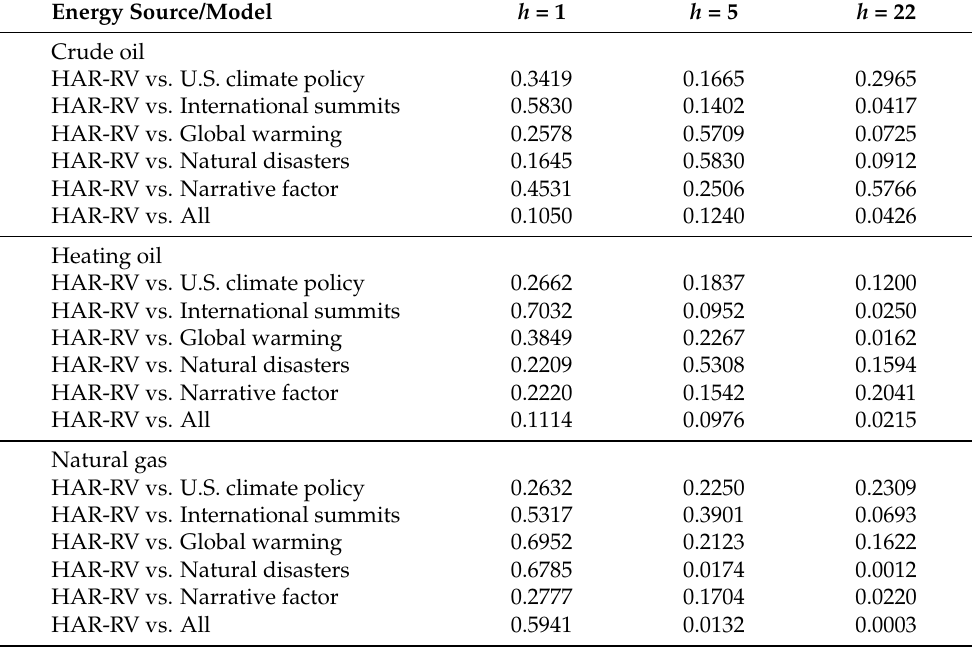
Table 7. Test results for a recursive-estimation window. Results ( p -values; robust heteroskedasticity and autocorrelation consistent standard errors) of the Clark–West tests for an equal mean-squared prediction error are based on robust standard errors. The classic HAR-RV model is the benchmark model, and the model extended to include climate-risk factors is the rival model. The alternative hypothesis is that the rival model has a smaller MSPE than the benchmark model. The parameter h denotes the forecast horizon (in days). The models are estimated using a recursive-estimation window, where we use 250 observations as a training period to initialize the